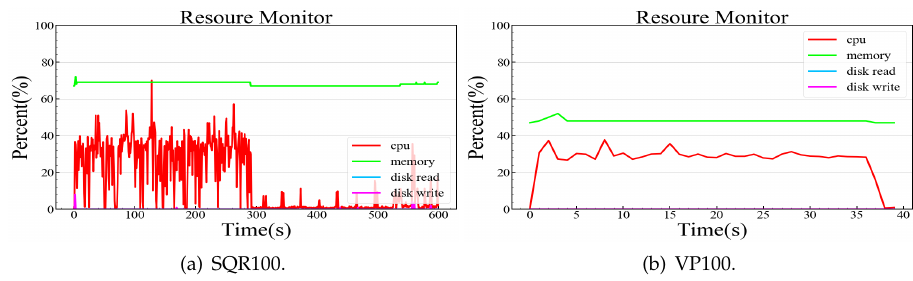
Figure 6. Simulating a local security center in a PC environment.